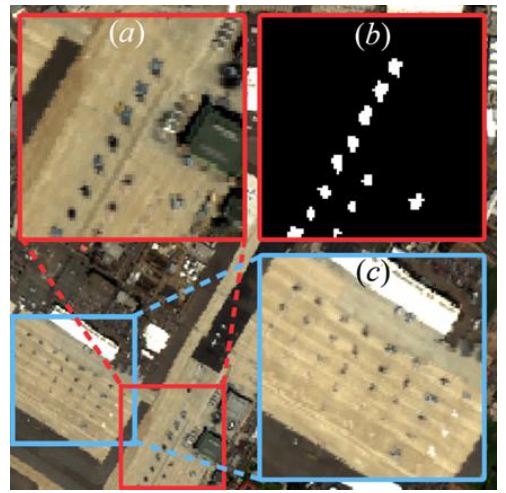
Figure 5. A natural color composite of the AVIRIS data cube, (a) sub-image with real targets (Img-II), (b) truth locations of targets in Img-II and (c) sub-image with real targets (Img-III) [14].